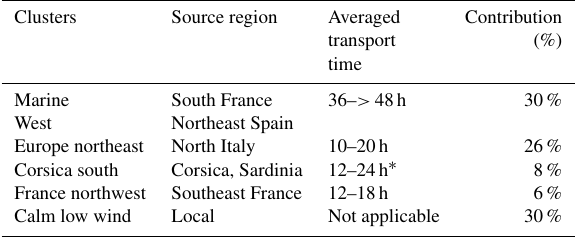
Table 2. Back-trajectory clusters for the ChArMEx SOP2 field cam- paign in Cape Corse. The averaged transport time corresponds to the time spent since the last anthropogenic contamination, i.e., since the air masses left the continental coasts.